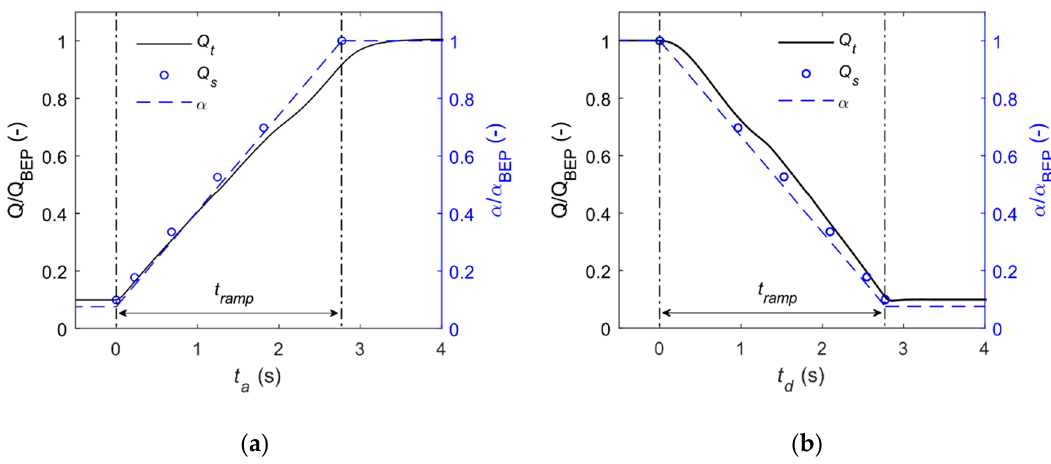
Figure 8. Flow rate variation over time, transient flow rate Q t . ( a ) During an acceleration and ( b ) during a deceleration. The ramp time for the transient, tramp, is 2.77 s. Q s is the steady flow rate obtained from the simulations at stationary GV angle (GVA) ( α ).